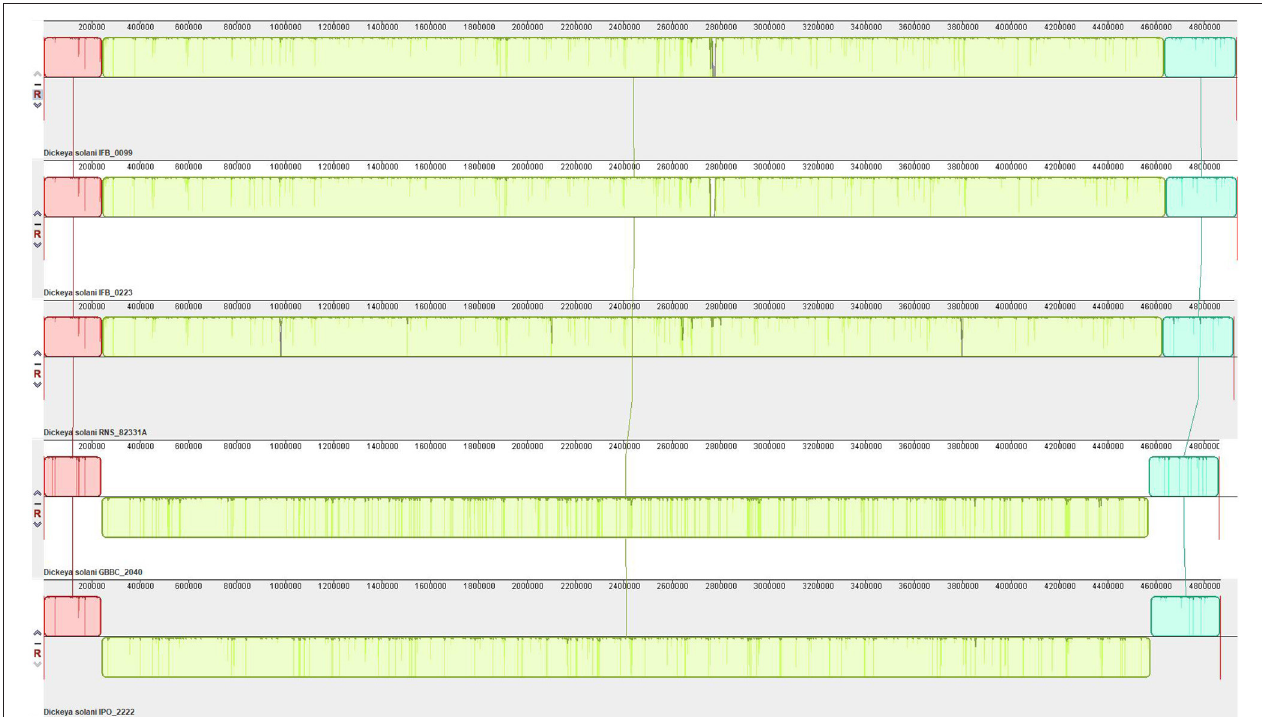
FIGURE 4 | Synteny of the D. solani genomes. Pairwise alignments of genomes were generated by Mauve 2.4.0 (development snapshot Mauve_2015_02_26). Inside each block a similarity profile of the genomic sequence is presented. Height of the similarity profile corresponds to the average level of genomic conservation in that region. Areas that are completely white were not aligned and probably contain sequence elements specific to a particular genome. Height of the similarity profile is inversely proportional to the average alignment column entropy over a region of alignment.